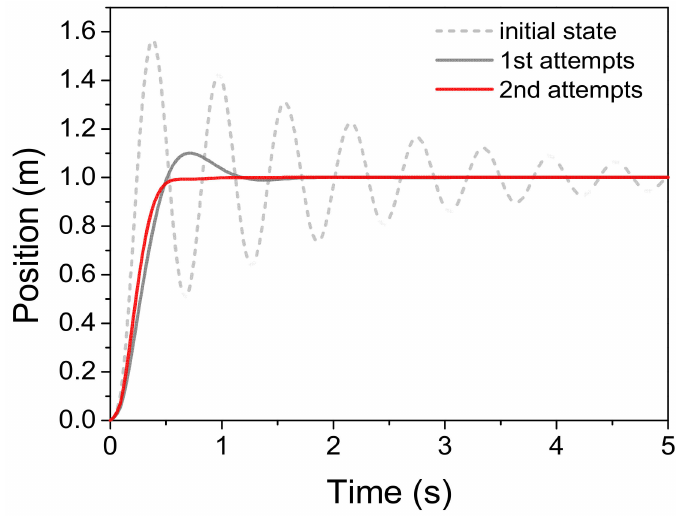
Figure 6. Response graphs with the changes as tuning was repeated when m = 187.77 kg, k = 318.47 N/m, and c = 88.65 N · s/m.